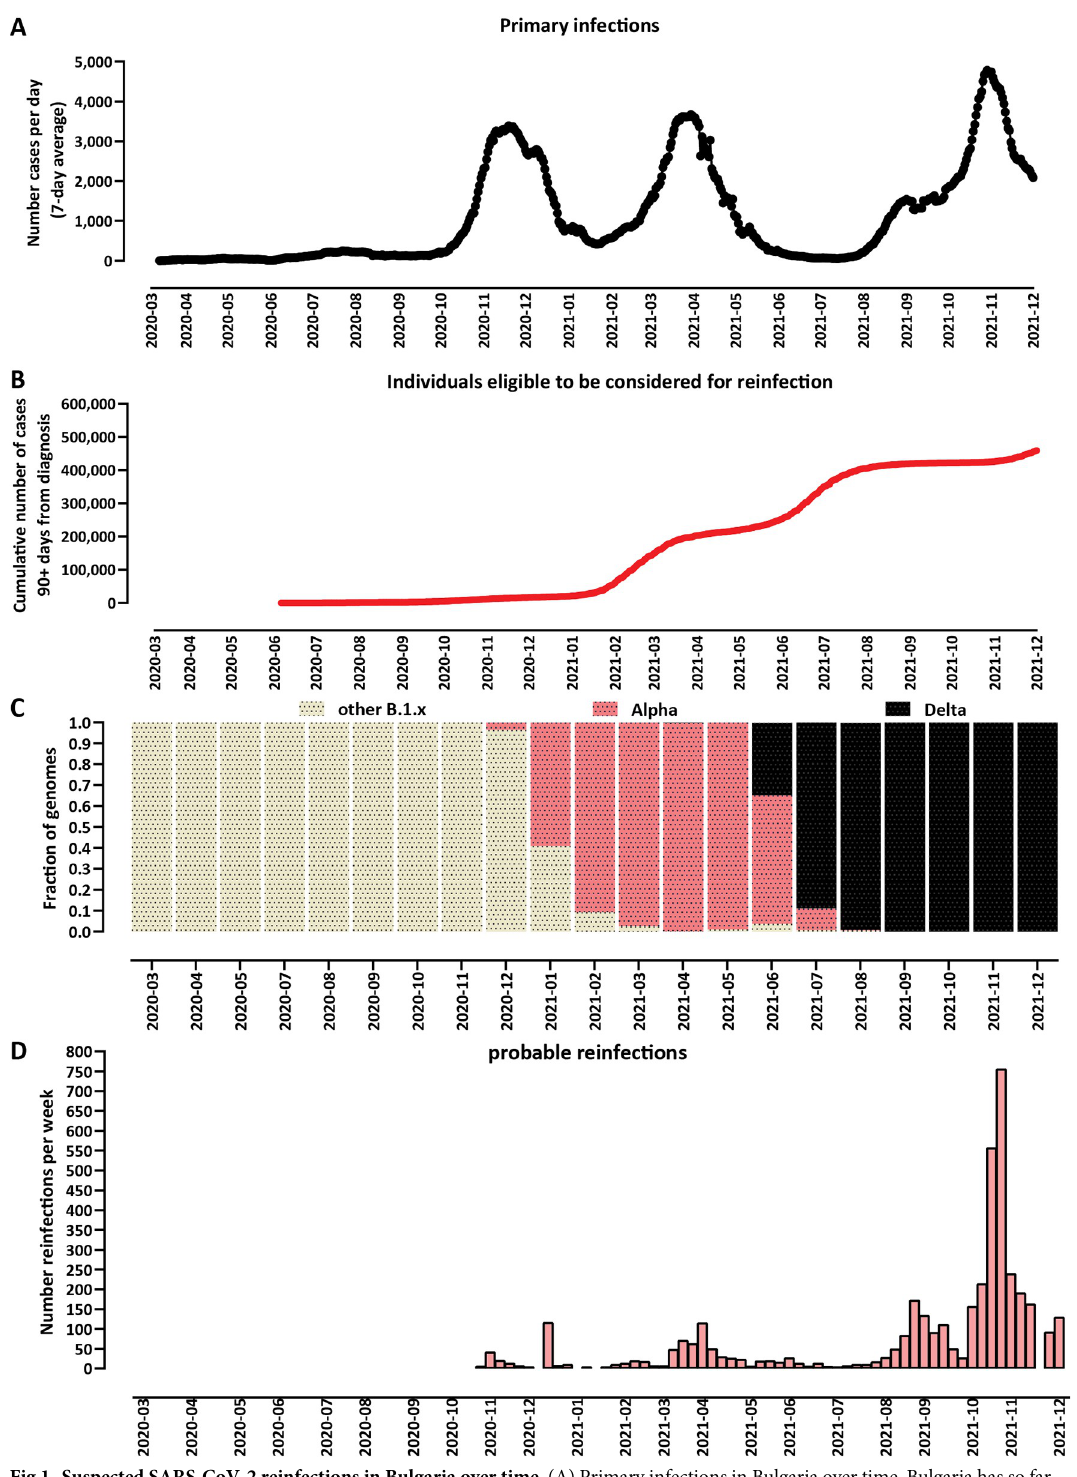
Fig 1. Suspected SARS-CoV-2 reinfections in Bulgaria over time. (A) Primary infections in Bulgaria over time. Bulgaria has so far experienced three distinct major epidemiological waves of COVID-19, with peaks in November 2020, March 2021, and October 2021 (an initial wave did occur in the first half of 2020 but it was very small and generally successfully suppressed, and is of little relevance to the progression of the pandemic in the country). (B) Number of people eligible to be considered for reinfection, i.e. people who have tested positive and � 90 days have elapsed since that positive test. (C) Dominant variants in Bulgaria over time. The first major